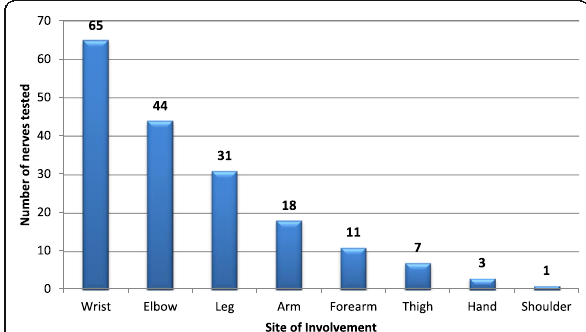
Fig. 2 Diagrammatic representation of the site of nerve pathology